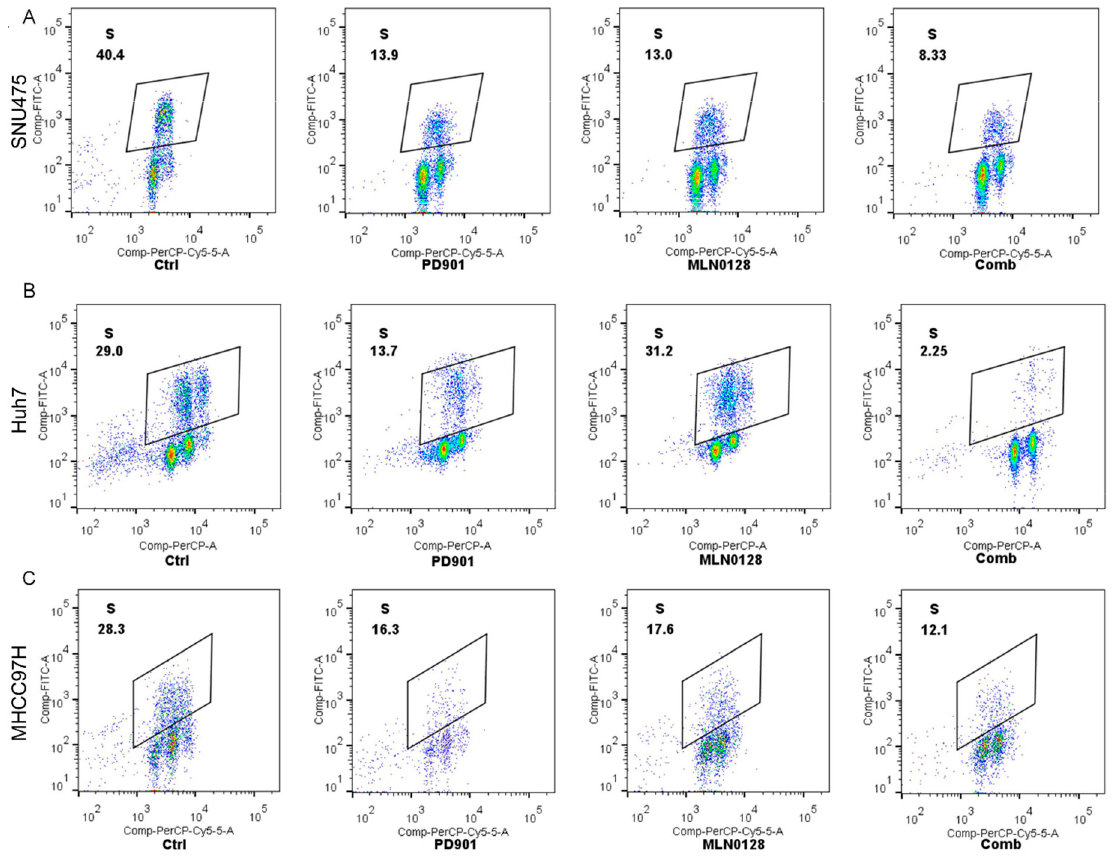
Figure 5. E ff ect of MLN0128 / PD901 combination on cell cycle of HCC cell lines. Enhanced cell cycle arrest in SNU475 ( A ), Huh7 ( B ), and MHCC97H ( C ) cell lines treated with PD901 plus MLN0128 when compared with treatment with PD901 and MLN0128 alone. The percentages of cells in the S phase are shown, together with representative dot plots. Abbreviations: Ctrl, Control; Comb, combined PD901 / MLN0128 treatment.